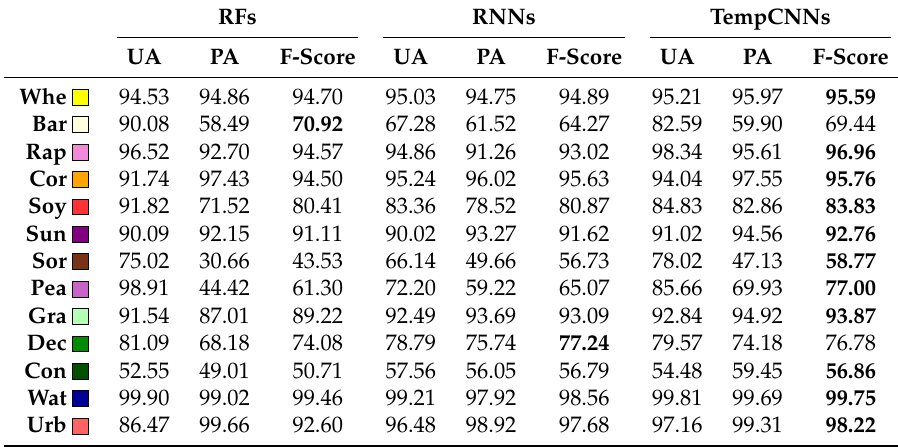
Table 4. Per-class quality measures. PA: producer’s accuracy. UA: user’s accuracy. Bold values represent the highest F-Score per class.